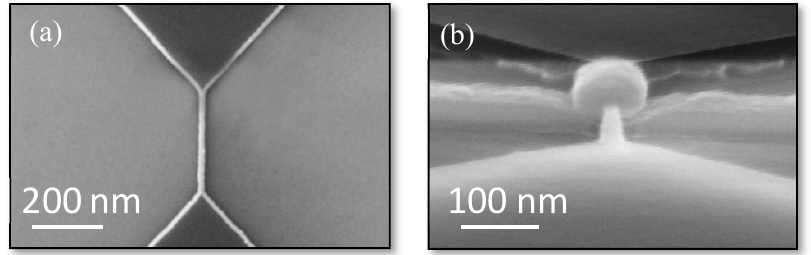
Figure 2. ( a ) Top view of a scanning electron microscope (SEM) image of a suspended silicon NW before gate fabrication process. ( b ) Side view of the final single NW TFET. It is clear that the gate metal completely wraps around the NW creating a gate-all-around (GAA) structure. The NW cross-section amounts to 35 nm × 10 nm.